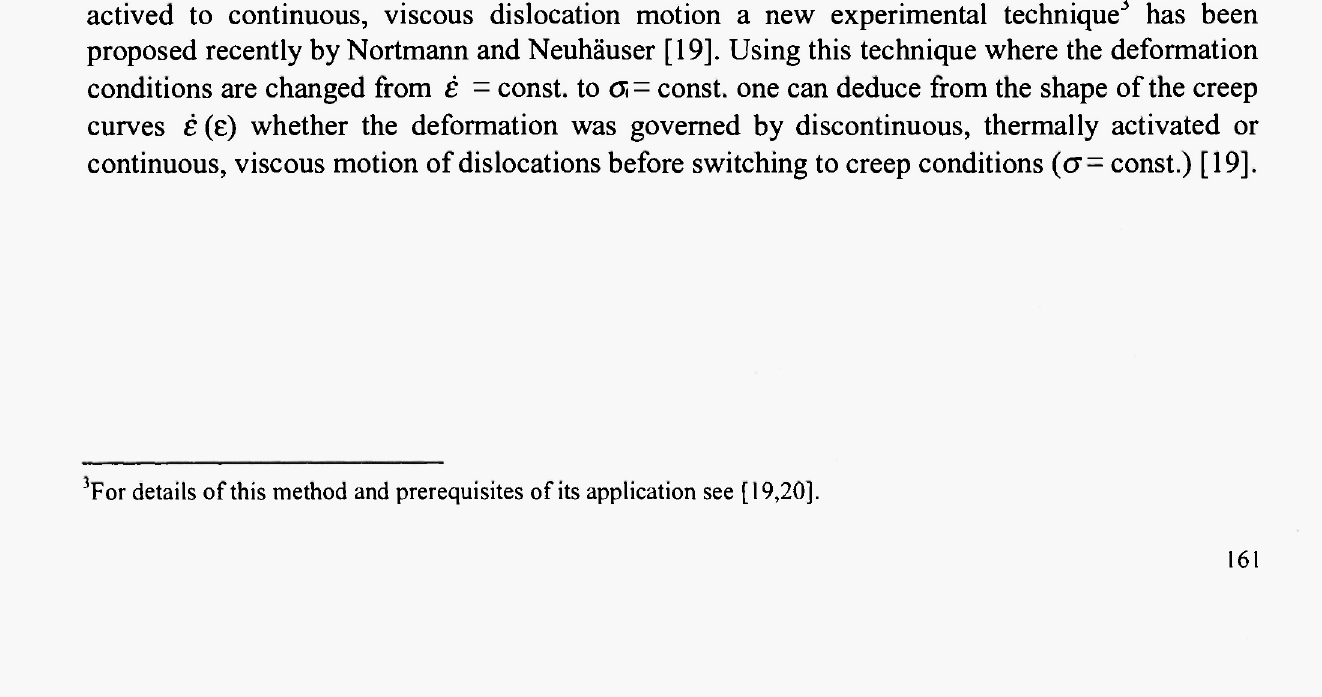
Figure 3: Dependence of the strain rate sensitivities (£,· and S for two different